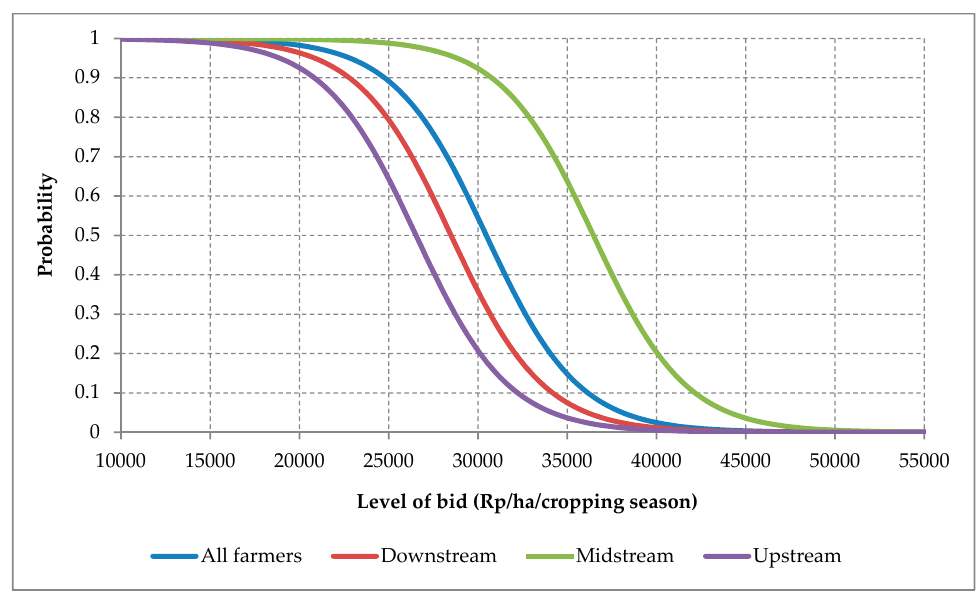
Figure 6. WTP of farmers in the downstream, midstream, and upstream areas.